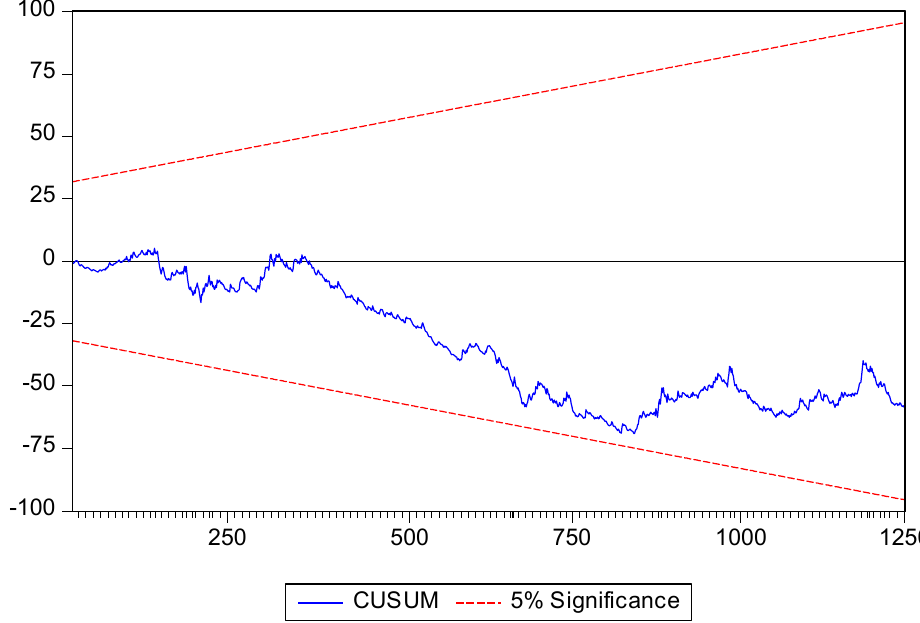
Figure 3. Plots of CUSUM of recursive residuals .